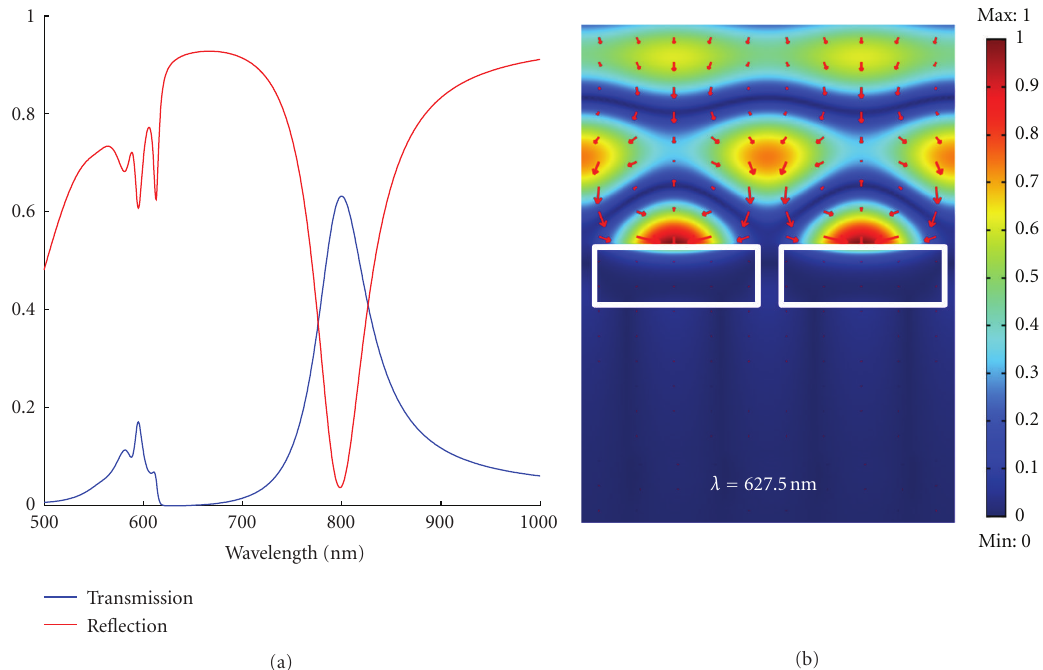
Figure 2: (a) Transmission and reflection diagrams of the free-standing array of metal stripes with w = 200nm, p = 600nm, l = 550 nm. (b) Map of the transversal section of the absolute value of the magnetic field computed at λ = 627.5 nm; red arrows display the direction of the Poynting vector.